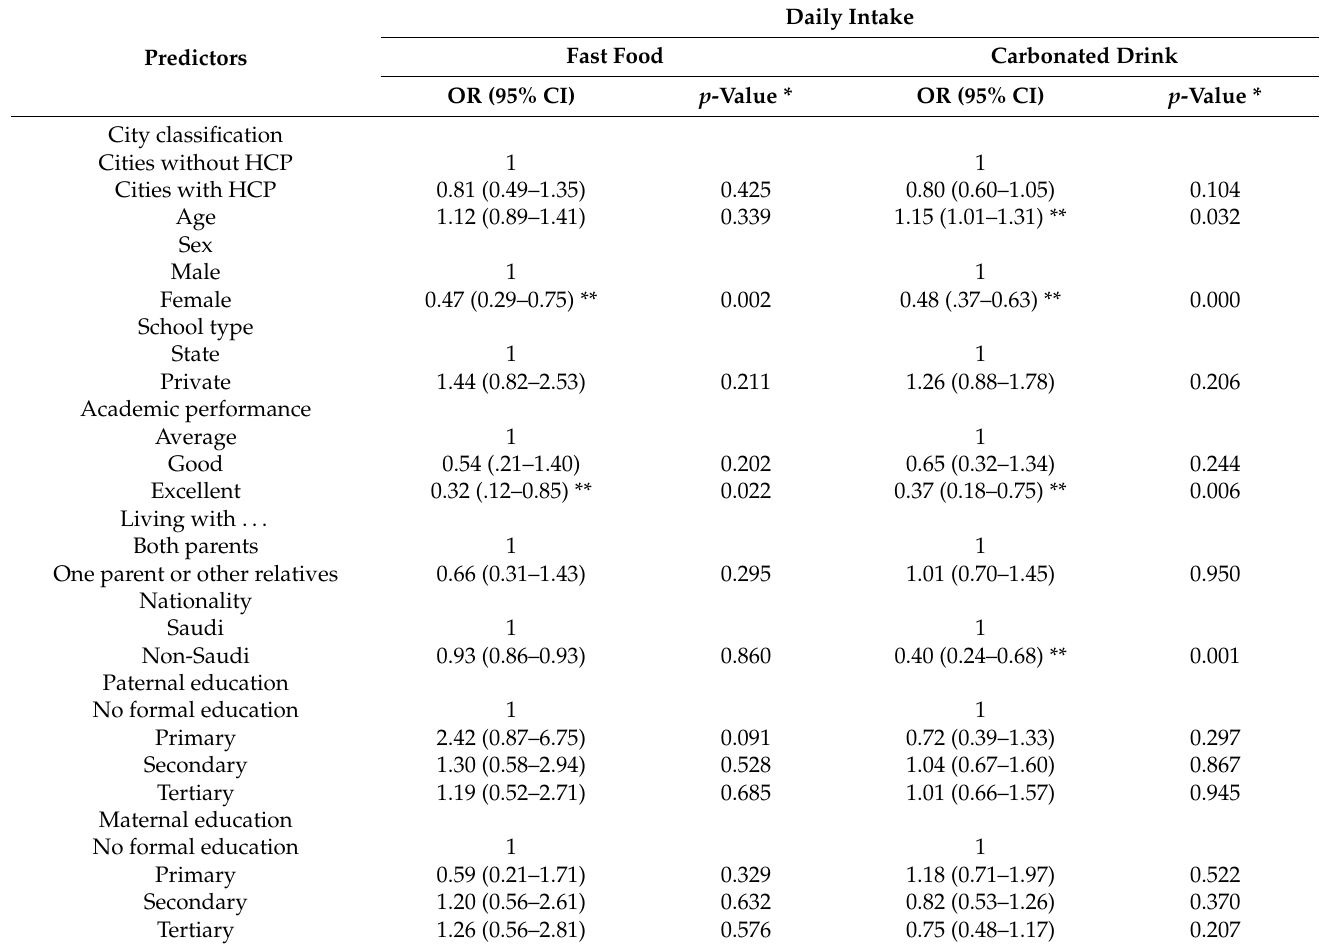
Table 5. Predictors of energy-dense food intake among adolescents in Qassim, Saudi